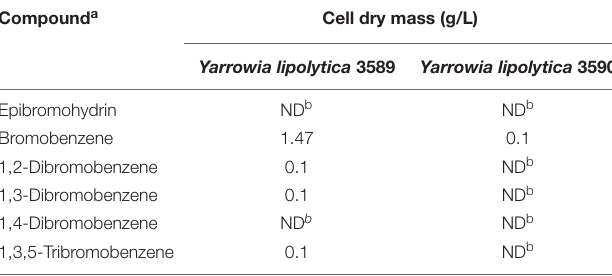
TABLE 1 | Cell growth on two strains of Yarrowia lipolytica when grown on different bromoaromatics. Compound